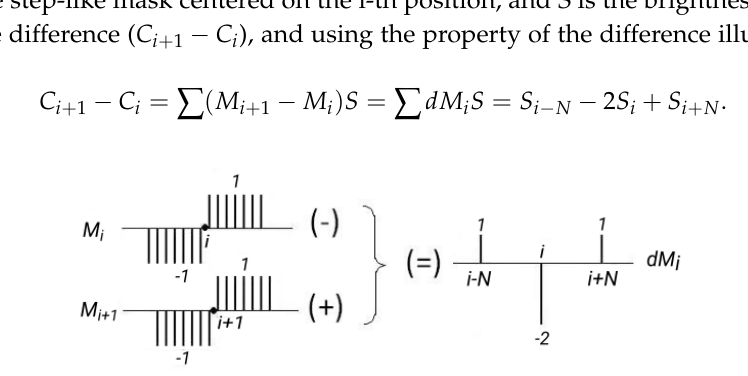
Figure 9. Property of the difference of two discrete step-like functions displaced by one sample.